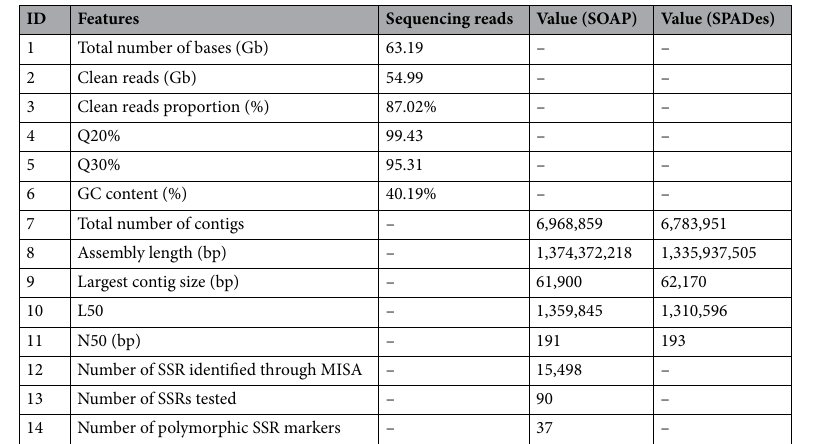
Table 1. Contigs and scaffolds of P. palustre .